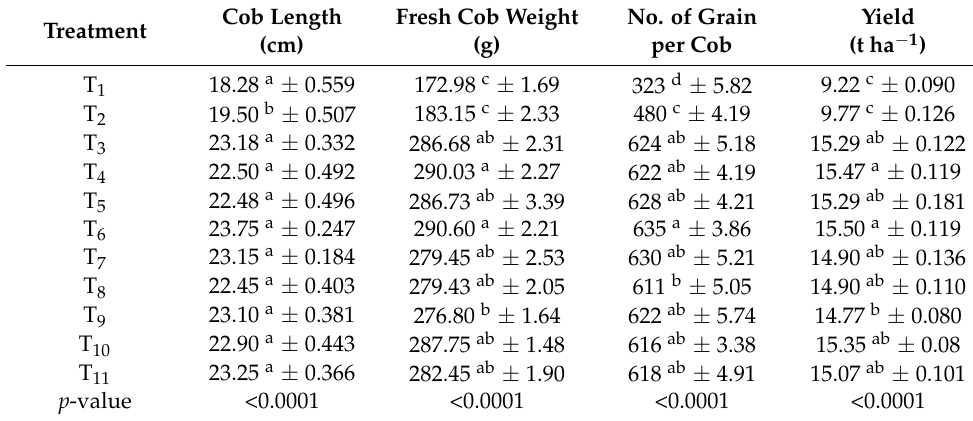
Table 6. Effect of treatments on yield contributing